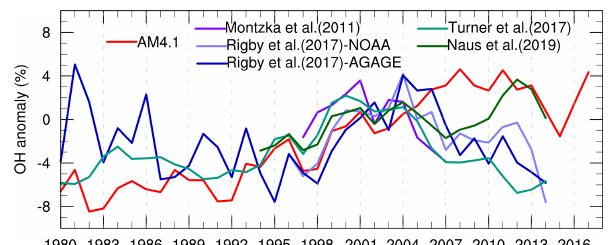
Figure 6. Time series of global tropospheric OH anomalies with re- spect to 1998–2007. Results of Montzka et al. (2011) are shown in dark purple (with the mean interannual variability of OH as ± 2 . 3% for the period of 1998–2007). Results of Rigby et al. (2017) derived from NOAA observations are shown in light blue (with the mean in- terannual variability of OH as ± 2 . 3% for the period of 1998–2007 and ± 2 . 6% for the period of 1980–2014), and those derived from AGAGE observations are shown in dark blue (with the mean inter- annual variability of OH as ± 3 . 0% for the period of 1998–2007 and ± 3 . 1% for the period of 1980–2014). Results from Turner et al. (2017) are shown in green (with the mean interannual variability of OH as ± 2 . 0% for the period of 1998–2007 and ± 2 . 5% for the period of 1980–2014). Results from Naus et al. (2019) are shown in dark green (with the mean interannual variability of OH as ± 1 . 2% for the period of 1998–2007 and ± 1 . 8% for the period of 1994– 2014). OH anomalies in this work are shown in red (with the mean interannual variability of OH as ± 2 . 2% for the period of 1998– 2007 and ± 4 . 1% for the period of